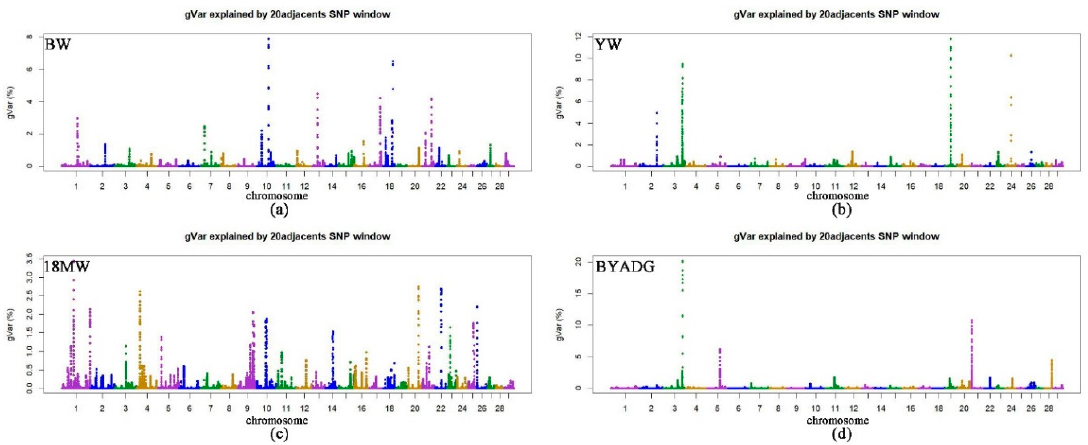
Figure 1. Manhattan plots for the percentage of genetic variance by 20 adjacent SNP windows for growth traits in Chinese Simmental beef cattle. gVar (%) represent the proportion of genetic variance explained by 20 adjacent SNPs. ( a ) BW: birth weight; ( b ) YW: yearling weight; ( c ) 18MW: body weight at the age of 18 months; ( d ) BYADG: average daily gain from birth to yearling.